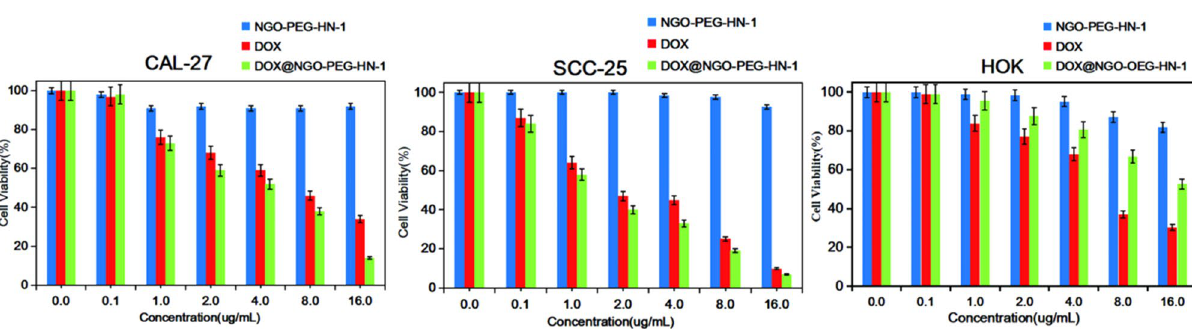
Figure 11. The Cell Viability of CAL-27 SCC-25 and HOK co-cultured with DOX, NGO-PEG-HN-1, and DOX@NGO-PEG-HN-1 for 24